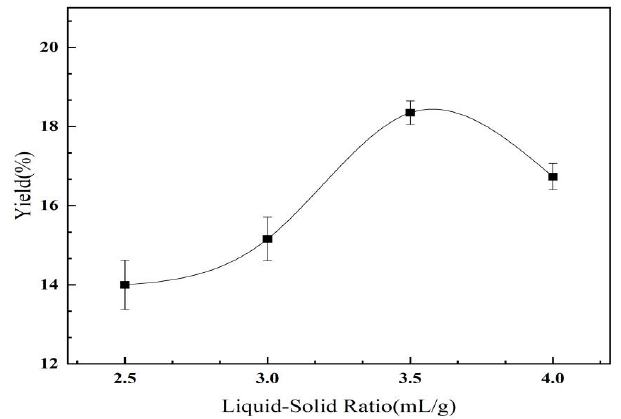
Figure 4. Influence of the extracted liquid–solid ratio on the yield of C. oleifera saponins (extraction temperature = 65 °C; methanol concentration = 75%; extraction time = 180 min).